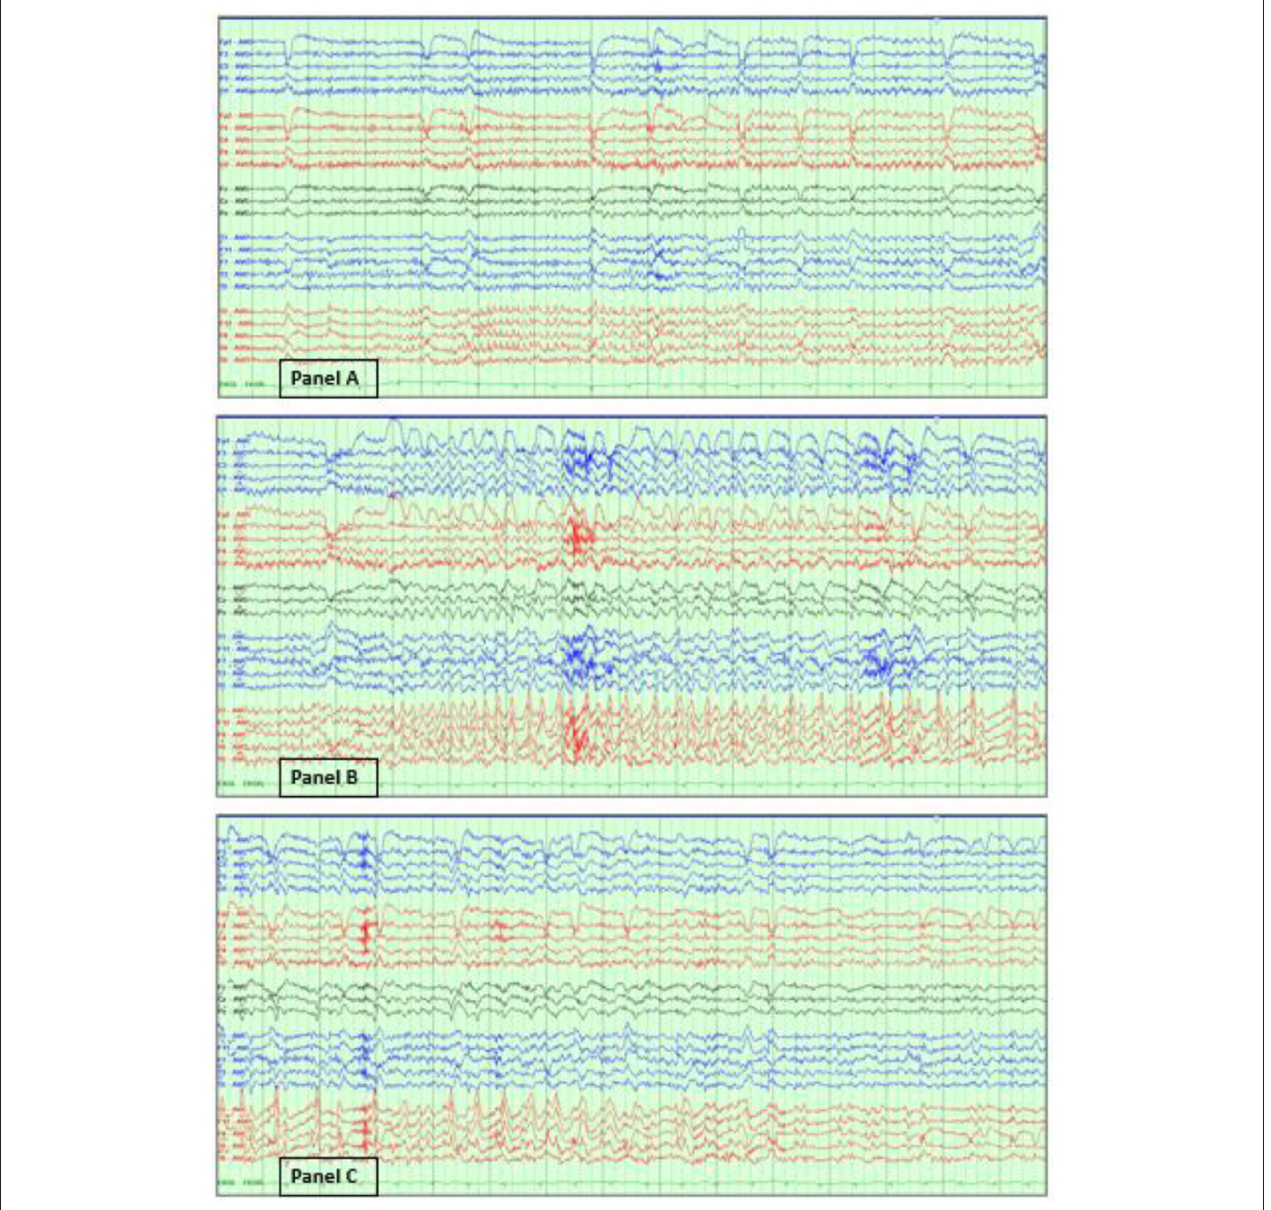
FIGURE 3 | Unequivocal electrographic seizure on EEG in the ICU. Right temporal electrographic seizure (A–C) in a 21-year-old woman with herpes simplex (HSV) encephalitis. Average referential montage with double density electrodes added in the bilateral basal temporal regions (T1, F11, T2, F12), LFF: 1Hz, HFF: 70Hz, Notch: 60Hz, Sensitivity: 10 µ V/mm, Timebase: 30